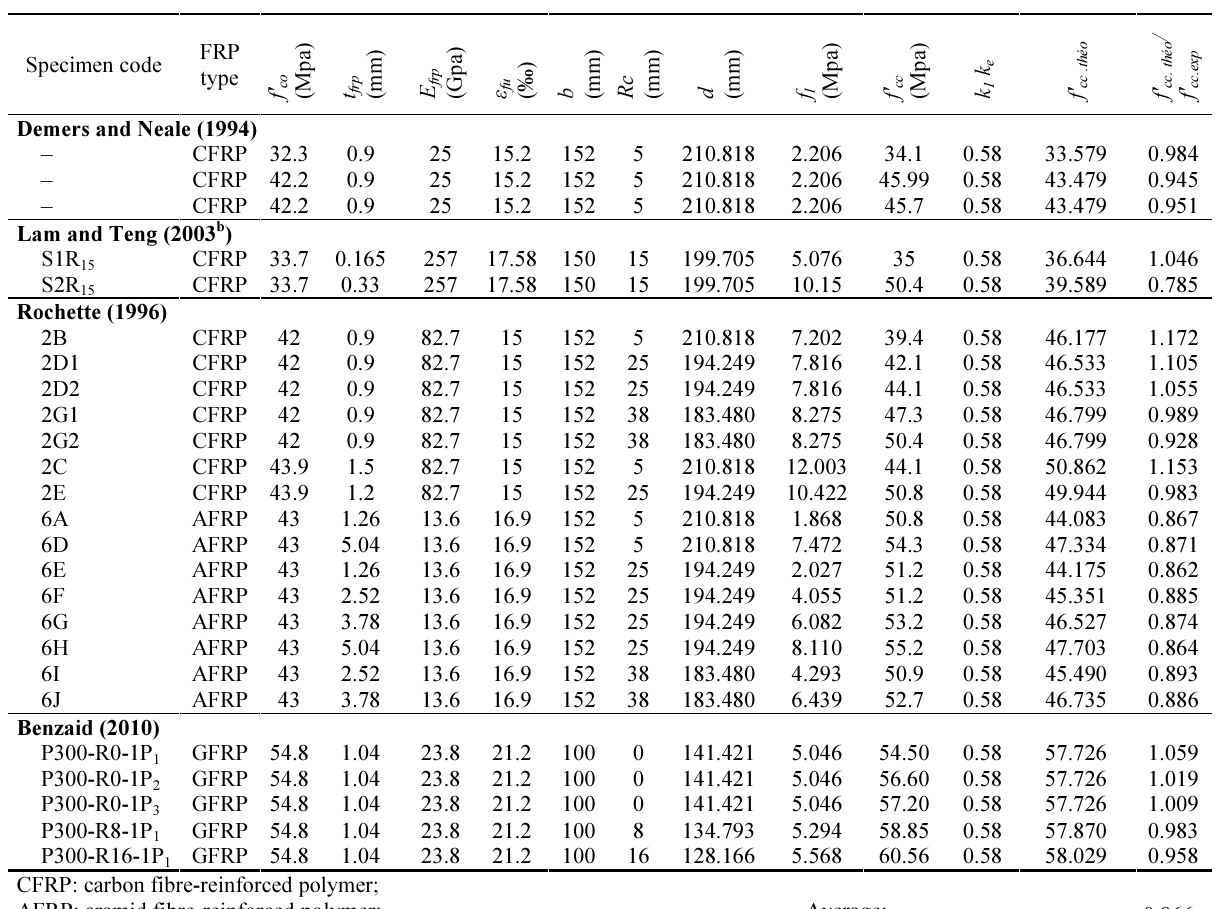
Table 9. Performance of proposed model: compressive strength